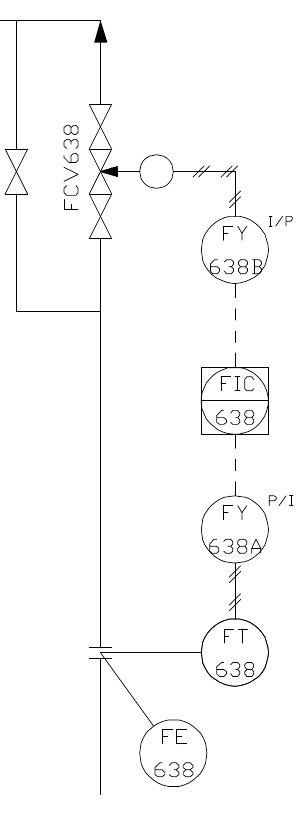
Figure 5. The considered flow control loop for the chemical